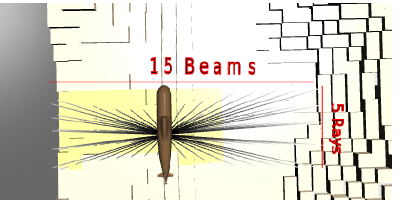
Figure 3. The simulator has 15 beams, each represented by five rays.